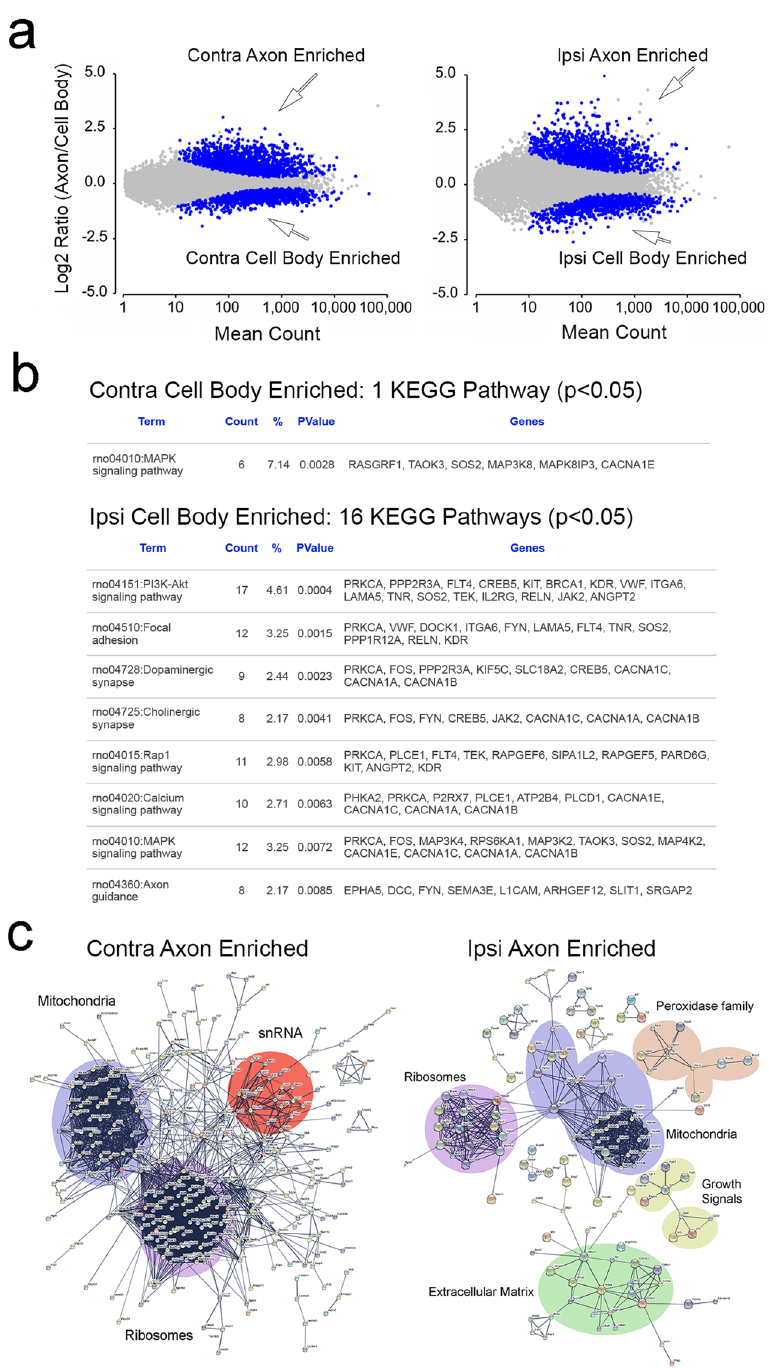
Figure 2. RNA-Seq analysis of enriched mRNAs in cell body and axon compartments. ( a ) Analysis of RNA-Seq reads processed by STAR aligner and DESeq2 revealed mRNA profiles in axon and cell body compartments of SNE ipsi and contralateral DRG neurons. In the log ratio and mean average (MA) plots, blue dots represent mRNAs exhibiting the compartment specific enrichment (q < 0.05). Note that SNE conditioning increased log raitos as shown by MA plot. ( b ) The mRNAs in the cell body compartments with the expression level ≥ 2.0 over the axon compartments were subjected to KEGG analysis. While 1 KEGG pathway was identified in mRNAs enriched in the control (contra) cell body compartment, 16 KEGG pathways were found in SNE-conditioned (ipsi) cell body compartments. ( c ) The enriched mRNAs in the axon compartments were subjected to global protein network analysis using the STRING tool. The contra axon compartment was largely composed of mRNAs associated with protein synthesis (ribosomal structure and catalytic enzymes) and mitochondrial structure and functions, as well as small nuclear RNA associated protein complex. In the ipsi axons, in addition to the ribosomal and mitochondria-associated mRNAs, an mRNA cluster of extracellular matrix (type VIII and type XV collagens) and matrix metalloproteinase was identified. In addition, smaller clusters of peroxidase family and growth signals were